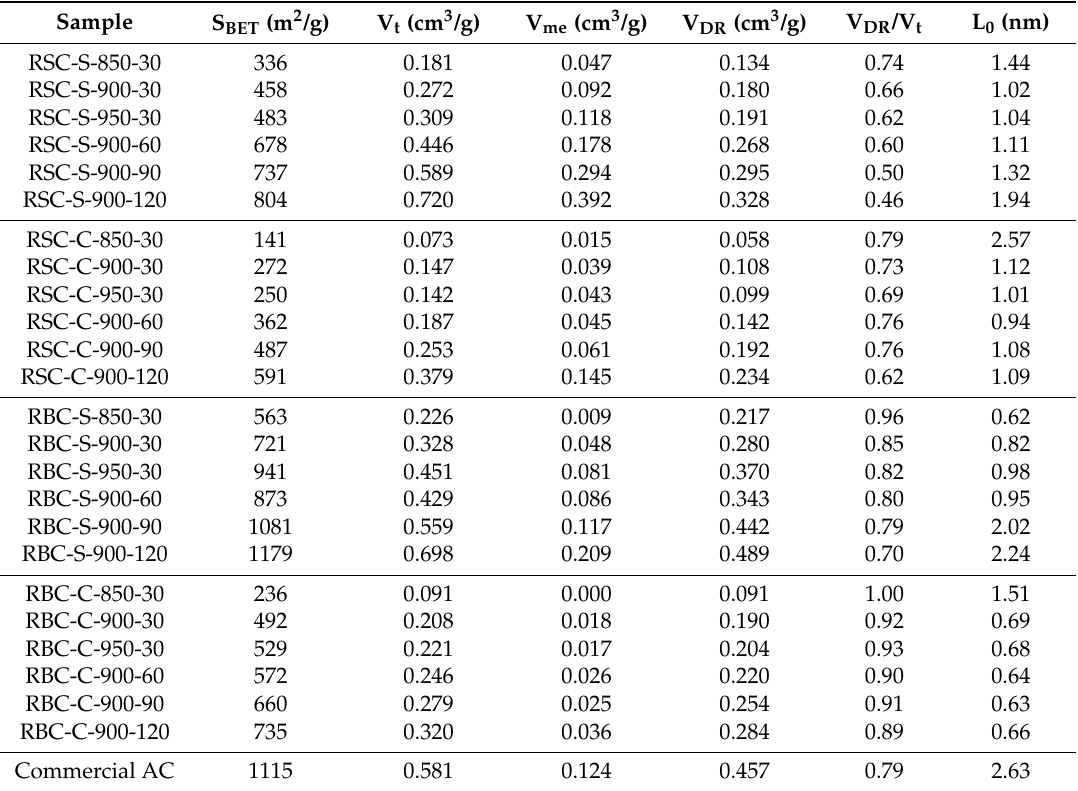
Table 2. Textural characteristics of ACs produced from RSC (after HCl washing) and RBC using various activation conditions. Commercial AC is included as a